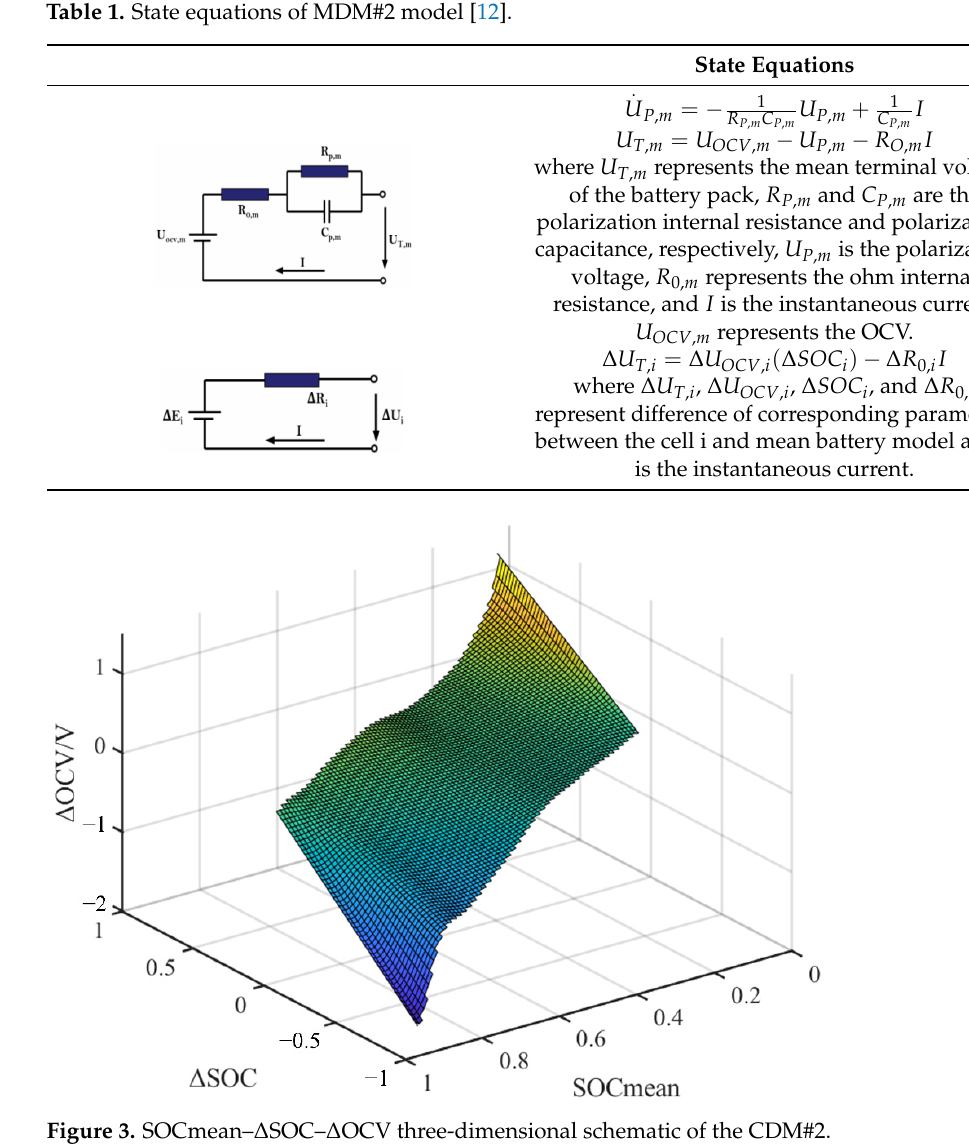
Figure 3. SOCmean– Δ SOC– Δ OCV three-dimensional schematic of the CDM#2. Figure 3. SOCmean– ∆ SOC– ∆ OCV three-dimensional schematic of the